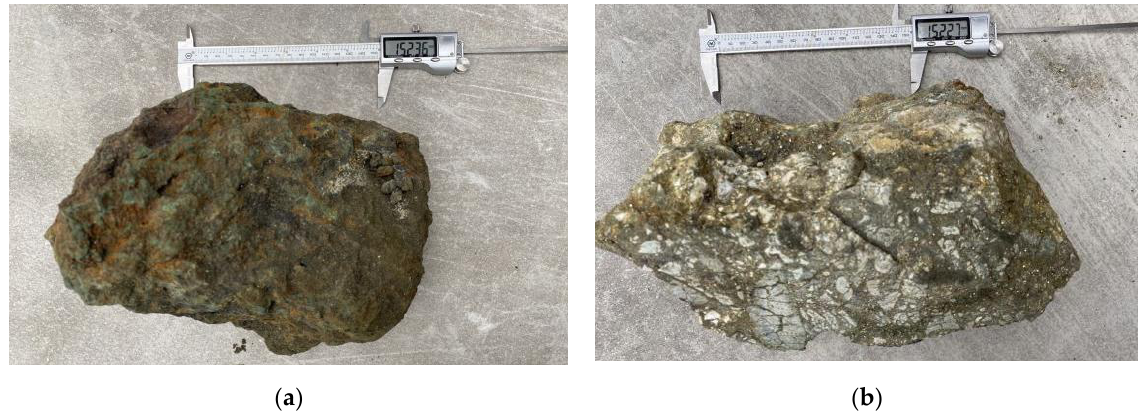
Figure 2. Original SMS samples. ( a ) black sample; ( b ) white sample.